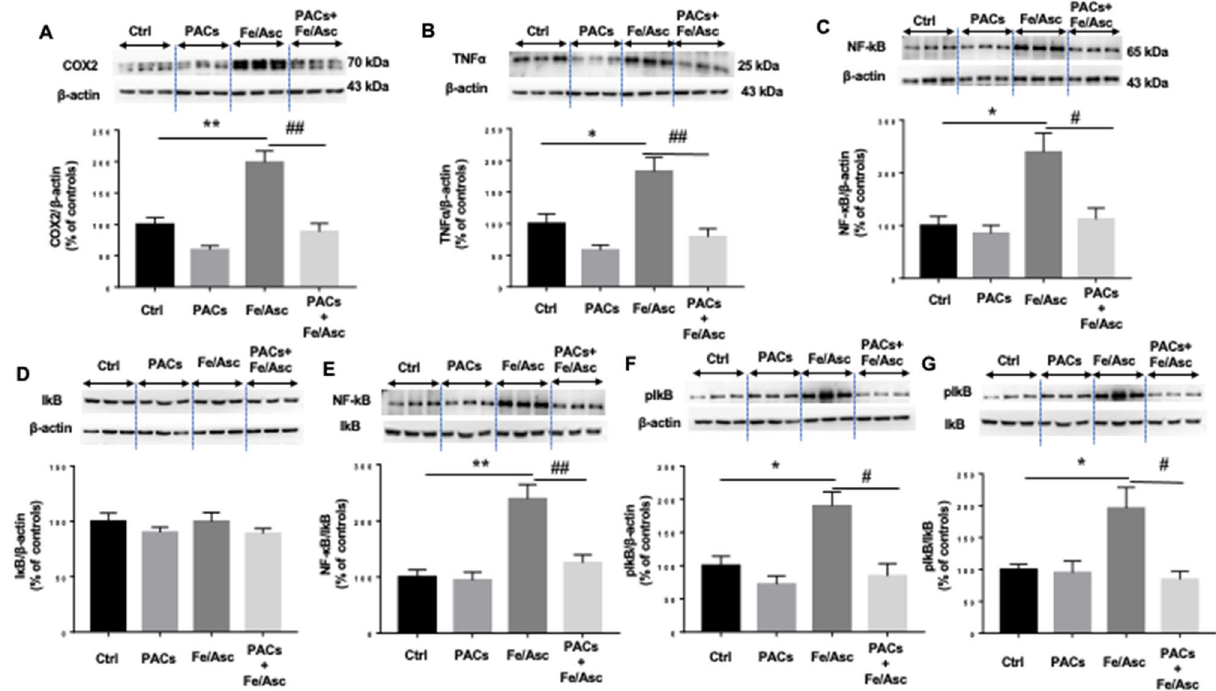
Figure 3. Effects of PACs on inflammatory markers and the key transcription factor NF-kB in Fe/Asc- induced inflammation in Caco-2/15 cells. Proanthocyanidins (PACs, 250 µg/mL) were added to the apical cell compartment for 24 h prior to treatment with Fe/Asc (200 µM/2 mM) for 6 h at 37 °C. Protein expressions of ( A ) COX2 and ( B ) TNFα, ( C ) NF-kB, ( D ) IkB and its ( F ) phosphorylated form (pIkB) were determined by Western blot. The ratios ( E ) NF-kB/IkB and ( G ) pIkB/IkB were calculated. Results represent the means ± SEM of 3 independent experiments, each in triplicate. A representative Western blot is shown, illustrating an experiment in triplicate on the same gel and with the same exposure. *P < 0.05; **P < 0.01 vs untreated cells (ctrl). # P < 0.05; ## P < 0.01 vs Fe/Asc treated cells. COX2 Cyclooxygenase-2, TNFα Tumor necrosis factor alpha, NF-κB nuclear transcription factor-kappa B, IκB Inhibitor of kappa